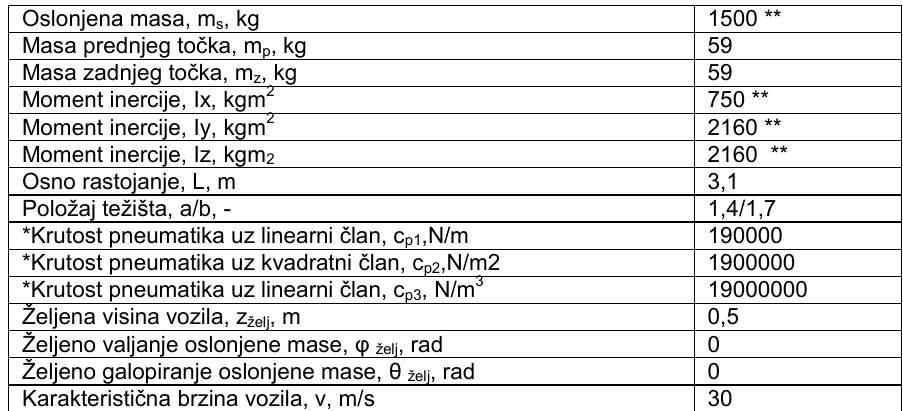
Tabela 1 – Osnovni podaci o parametrima vozila Table 1 – Basic data on vehicle